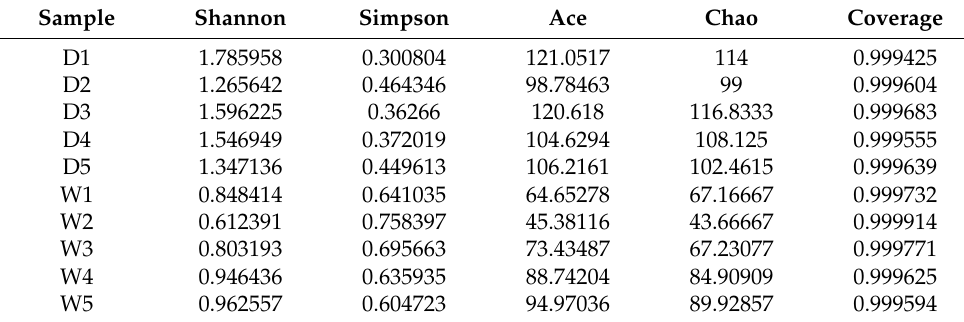
Table 1. Bacterial Alpha Diversity Table